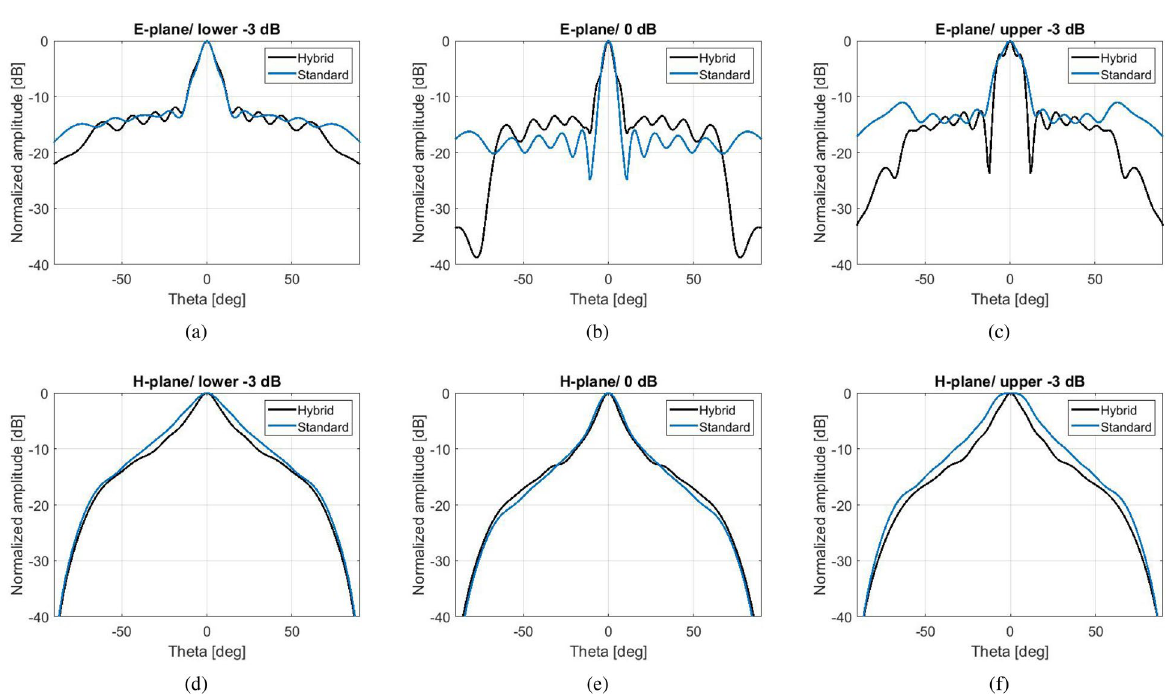
Figure 11. Simulated radiation patterns of the hybrid antenna with enhanced 3-dB gain bandwidth and the standard antenna of similar maximum